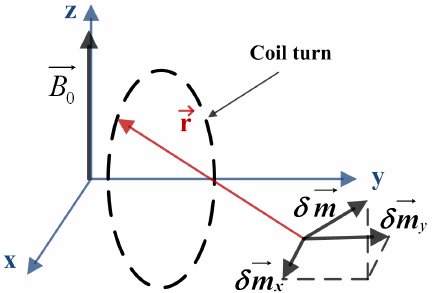
Figure 2. Illustration of the local elementary magnetization ( δ m ) position with respect to the coil turn for the vector potential calcu- lation over the